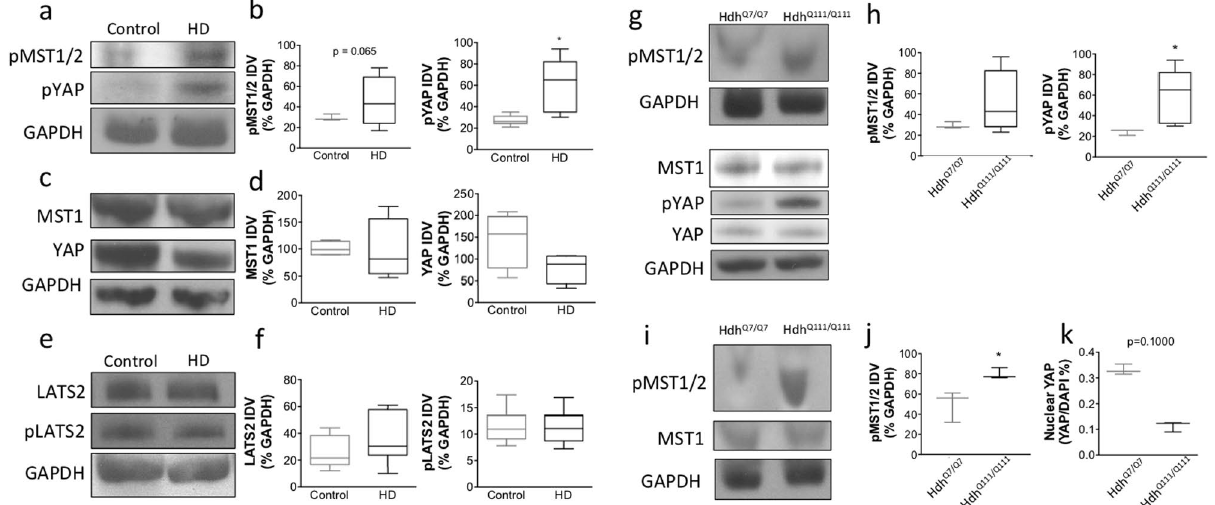
Figure 3. MST1/2 is activated and YAP is inactivated in post-mortem human cortex and the Hdh mouse model of HD. ( a ) Representative western blots for pMST1/2, pYAP and GAPDH (top to bottom) with human cortex samples from unaffected control (left; n = 4) and HD (right; n = 4) patients. ( b ) There was a trend towards an increase (p = 0.065, Mann-Whitney U Test) in pMST1/2 levels (left) from HD compared to controls. pYAP protein levels (right) were significantly increased (p = 0.015, Mann-Whitney U Test) in HD compared to controls. ( c ) Representative western blots for MST, YAP and GAPDH (top to bottom) with human cortex samples from unaffected control (left; n = 4) and HD (right; n = 4) patients. ( d ) There was no change in MST1 (left) (p = 0.343, Mann-Whitney U Test) or YAP (right) (p = 0.200, Mann-Whitney U Test) between HD and controls. ( e ) Representative western blots for LATS2, pLATS2 and GAPDH (top to bottom) with human cortex samples from unaffected control (left; n = 8) and HD (right; n = 8) patients. ( f ) There was no change in LATS2 (left) (p = 0.2039, Mann-Whitney U Test) or pLATS2 (right) (p = 0.8785, Mann-Whitney U Test) in HD compared to controls. ( g ) Representative western blots for phosphorylated MST1/2 (pMST1/2) and GAPDH (top to bottom) from HdhQ7/Q7 (left; n = 3) and HdhQ111/Q111 (right; n = 4) striatum and for MST1, phosphorylated YAP (pYAP), YAP and GAPDH (top to bottom) from Hdh Q7/Q7 (left; n = 3) and Hdh Q111/Q111 (right; n = 5) striatum. ( h ) Quantification of westerns blots showed no change in pMST1/2 (left) (p = 0.4000, Mann-Whitney U Test) and increased pYAP (right) (p = 0.0357, Mann-Whitney U Test) protein levels in Hdh Q111/Q111 relative to Hdh Q7/Q7 striatum. ( i ) Representative western blots for pMST1/2, MST1, and GAPDH (top to bottom) from Hdh Q7/Q7 (left; n = 3) and Hdh Q111/Q111 (right; n = 4) cortex. ( j ) Quantification of western blots shows increased pMST1/2 (p = 0.0286, Mann-Whitney U Test) protein levels in Hdh Q111/Q111 (right; n = 4) relative to Hdh Q7/Q7 (left; n = 4) cortex. ( k ) Quantification of immunofluorescence staining illustrated a trend towards a decrease (p = 0.1000, Mann-Whitney U Test) in nuclear YAP (YAP/DAPI%) levels in Hdh Q111/Q111 (n = 3) relative to Hdh Q7/Q7 (n = 3) samples. Data are presented as median and min-max values. * p <